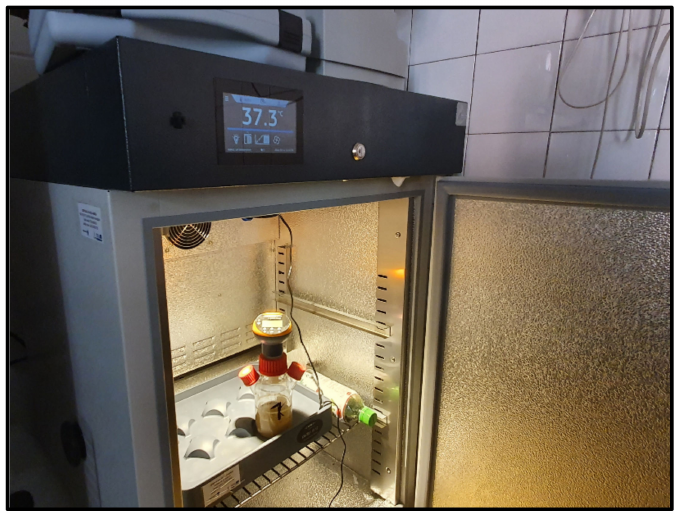
Figure 3. Incubation of AD